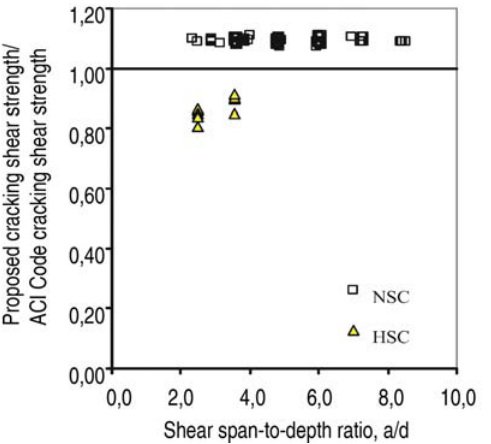
Fig. 3. Comparing proposed cracking shear strength of Eq (15) with ACI Code for various shear span-to-depth ratios